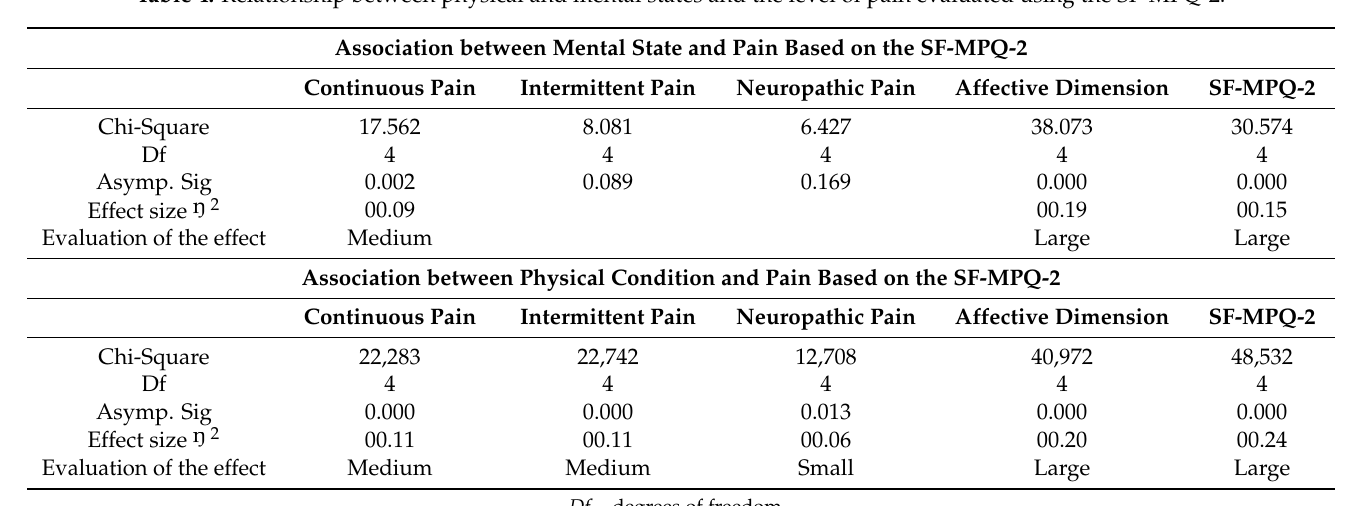
Table 5. Association of the total SF-MPQ-2 score with patient age.